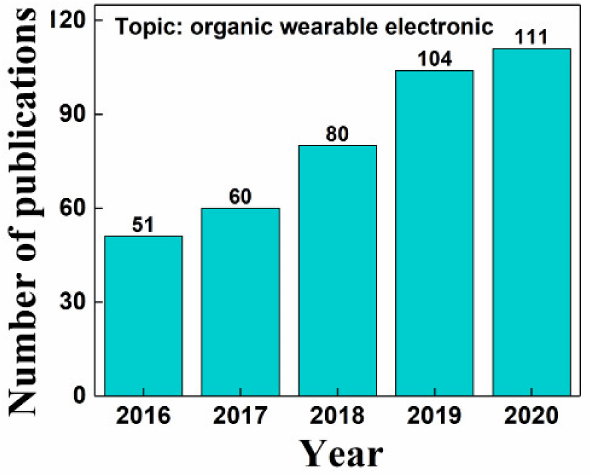
Figure 1. Number of publications referring to the topic “organic wearable electronic” published between 2016 and 2020 (source: web of science